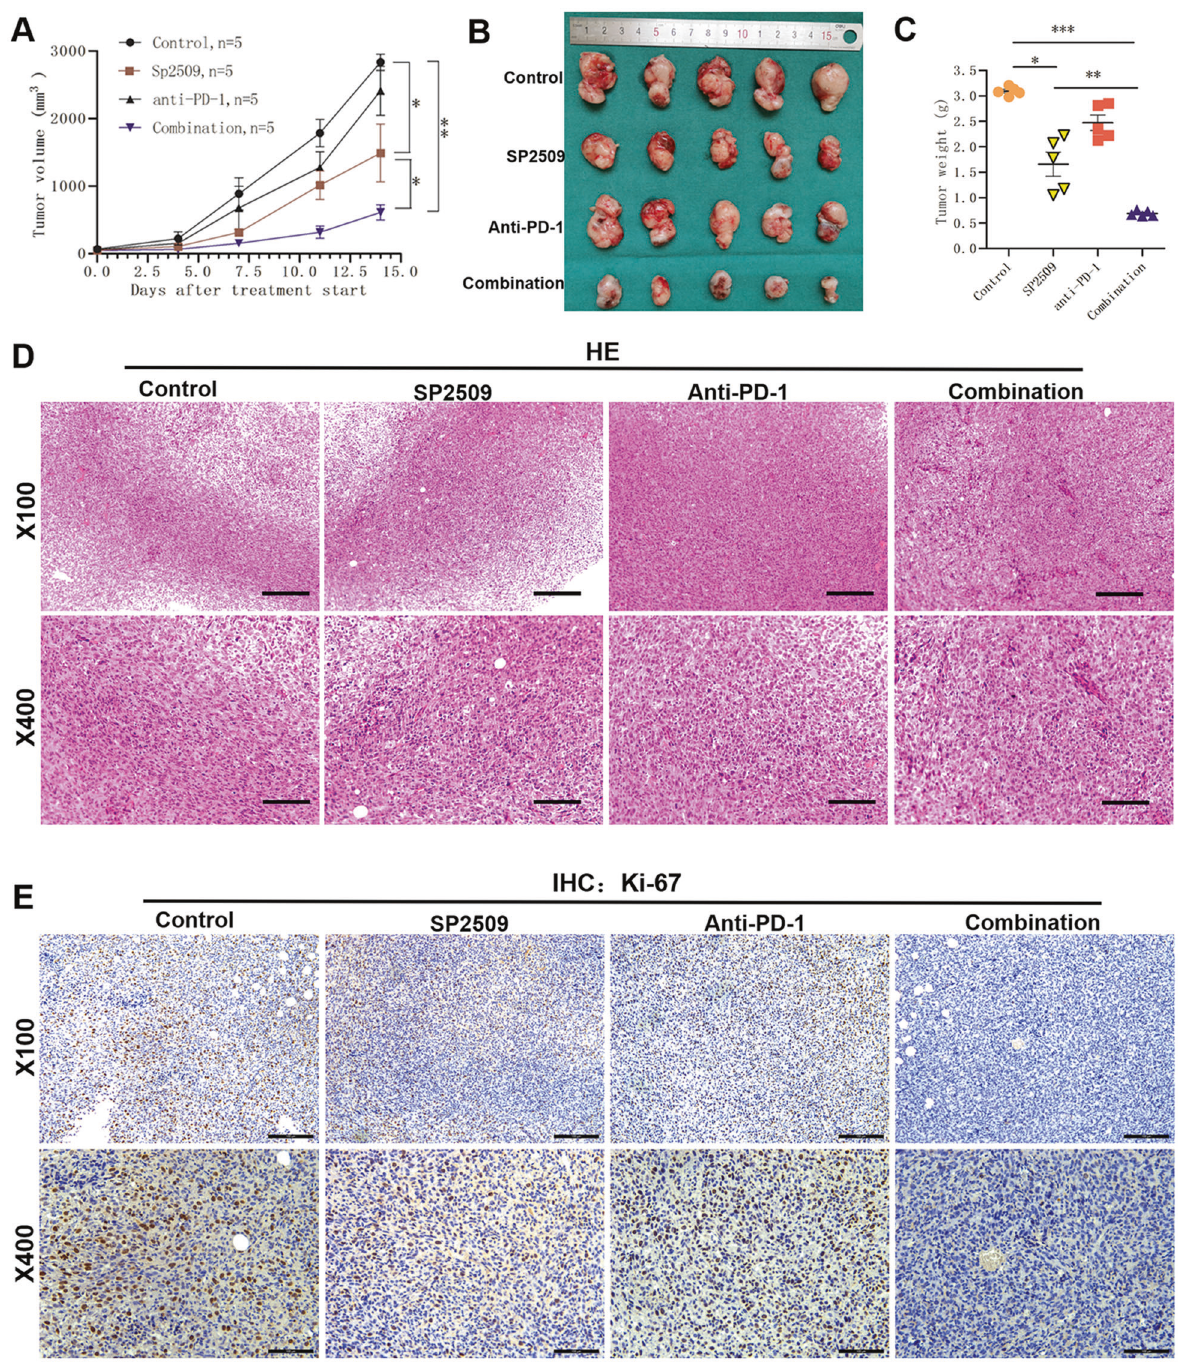
( n = 7) via i.p. injection. Tumors were measured with calipers, and values were plotted. The vertical bars indicate the mean tumor size (mm 3 ) ±SE. B SCC7 tumors in each group were harvested and photographed at the end of the experiment. Photographs of the xenograft tumors are shown. C Tumor weights were measured for each treatment group at autopsy. D Representative HE staining of SCC7 xenograft tumors treated with vehicle, SP2509, the anti-PD-1 mAb, or SP2509 + anti-PD-1 mAb. E Representative immunohistochemical staining for Ki-67 in